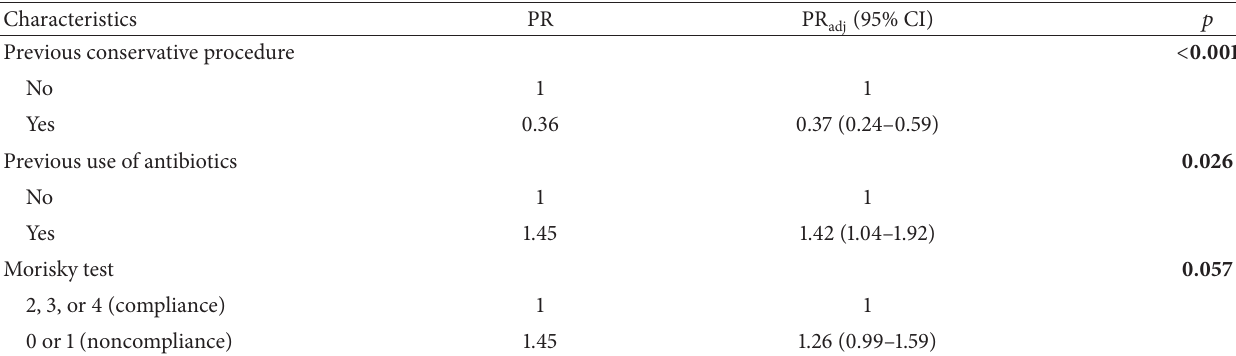
Table 5: Morisky test. Estimate of the prevalence ratio of the outcome to foot amputation in patients with diabetes using the Cox multiple regression